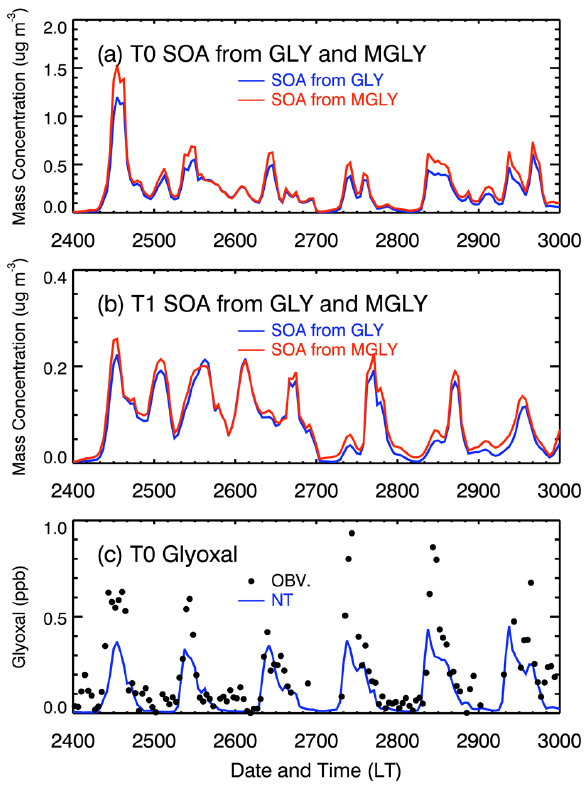
Figure 8 Fig. 8. Diurnal profiles of (a) SOA concentrations from glyoxal and methylglyoxal at T0, (b) at T1, and (c) glyoxal concentrations at T0. In (a) and (b) , the red and blue lines represent the SOA contributions from glyoxal and methylglyoxal, respectively. In (c) , black dots are measurements and blue line denotes the simulations in the NT-SOA